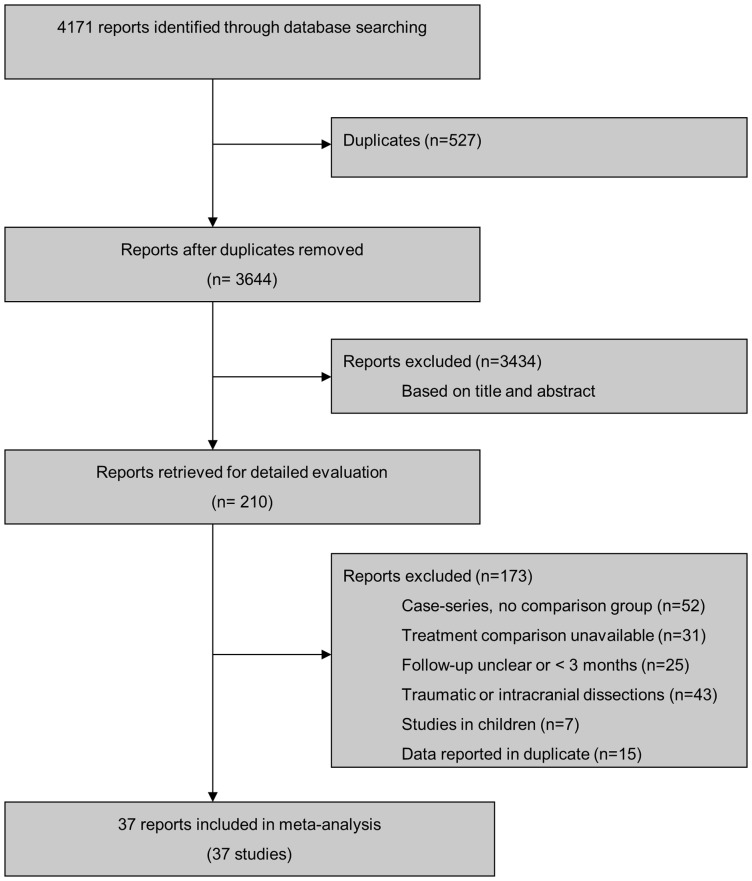
Study flow diagram.